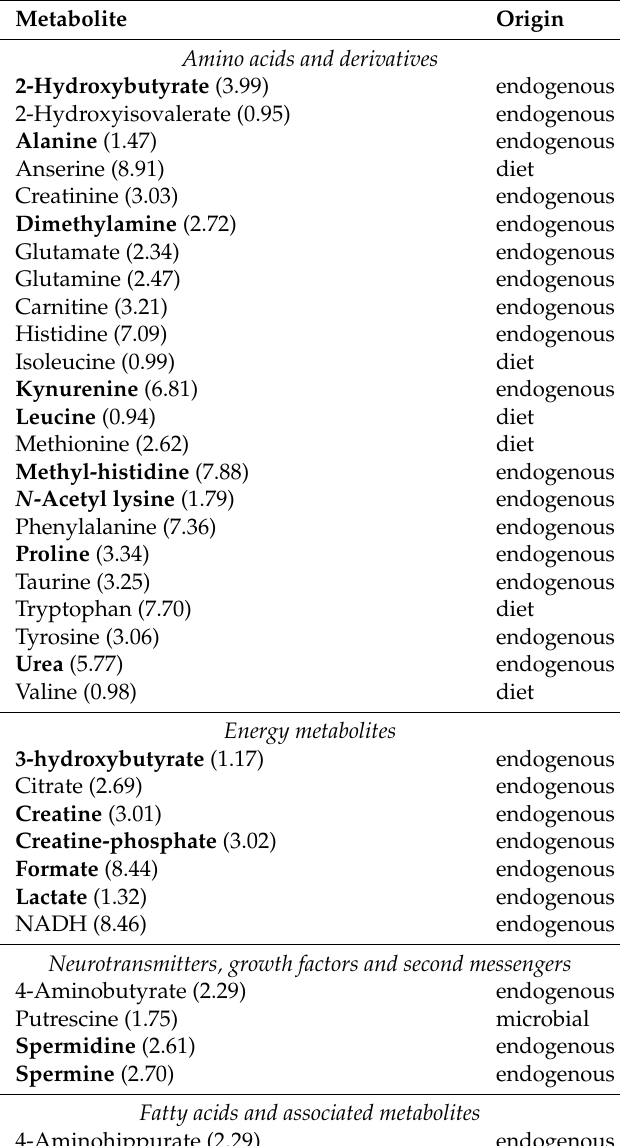
Table 1. Human milk metabolites identified in breast milk samples and their probable origin. Chemical shifts in ppm are presented (in